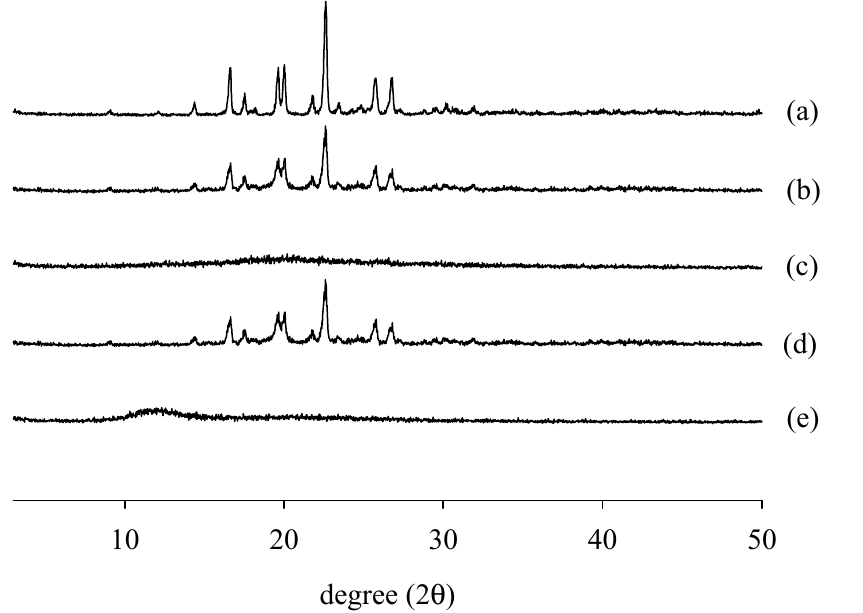
Figure 7. Comparison of Powder X-ray diffraction: (a) RXB powder; (b) physical mixture of RXB and gelatin (1:5); (c) gelatin-based solid dispersions (1:5); (d) physical mixture of RXB and PVA (1:0.5); (e) PVA-based solid dispersions (1:0.5).